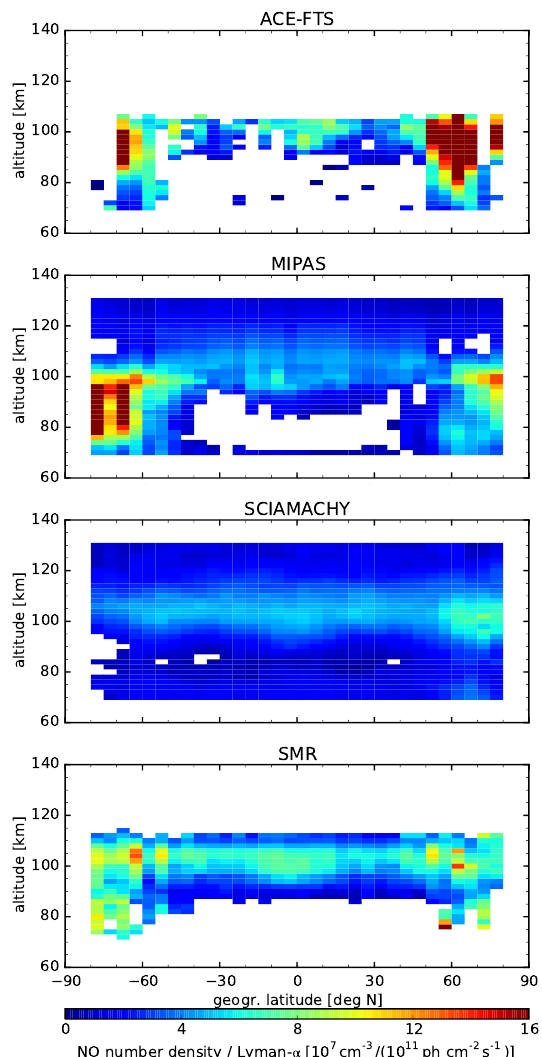
Figure 18. NO regression coefficient b of the long-term solar UV variations from the Lyman- α index as in Fig.